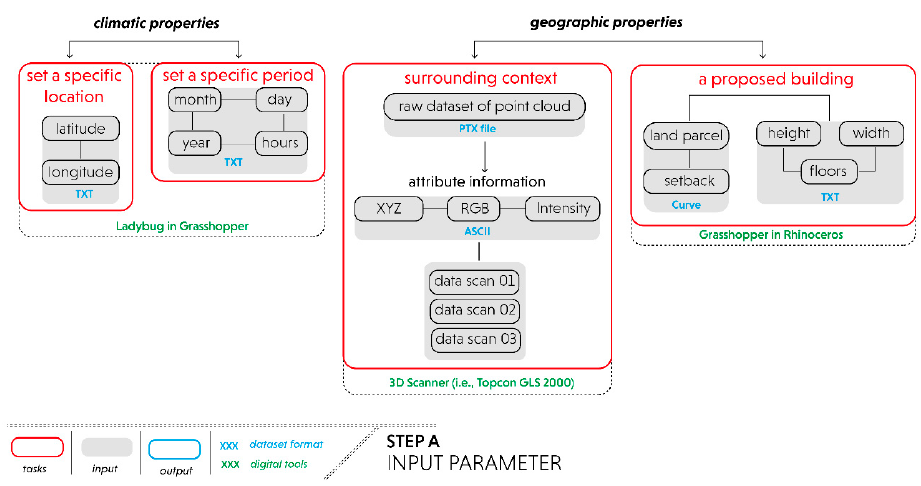
Figure 2. Preparation of input parameters.